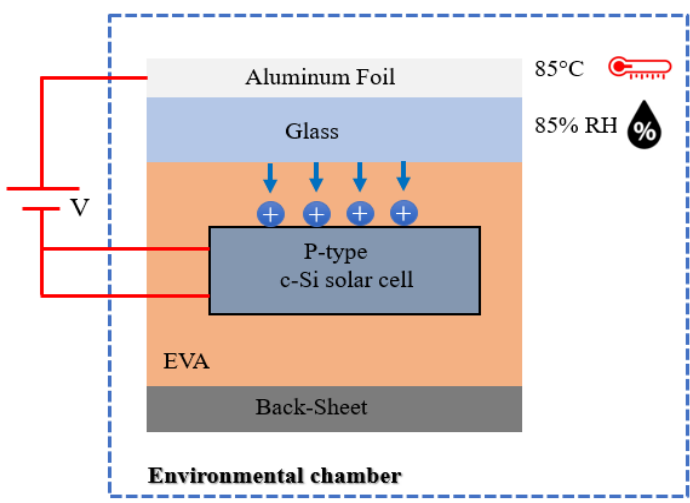
Figure 2. Schematic of PID test setup.